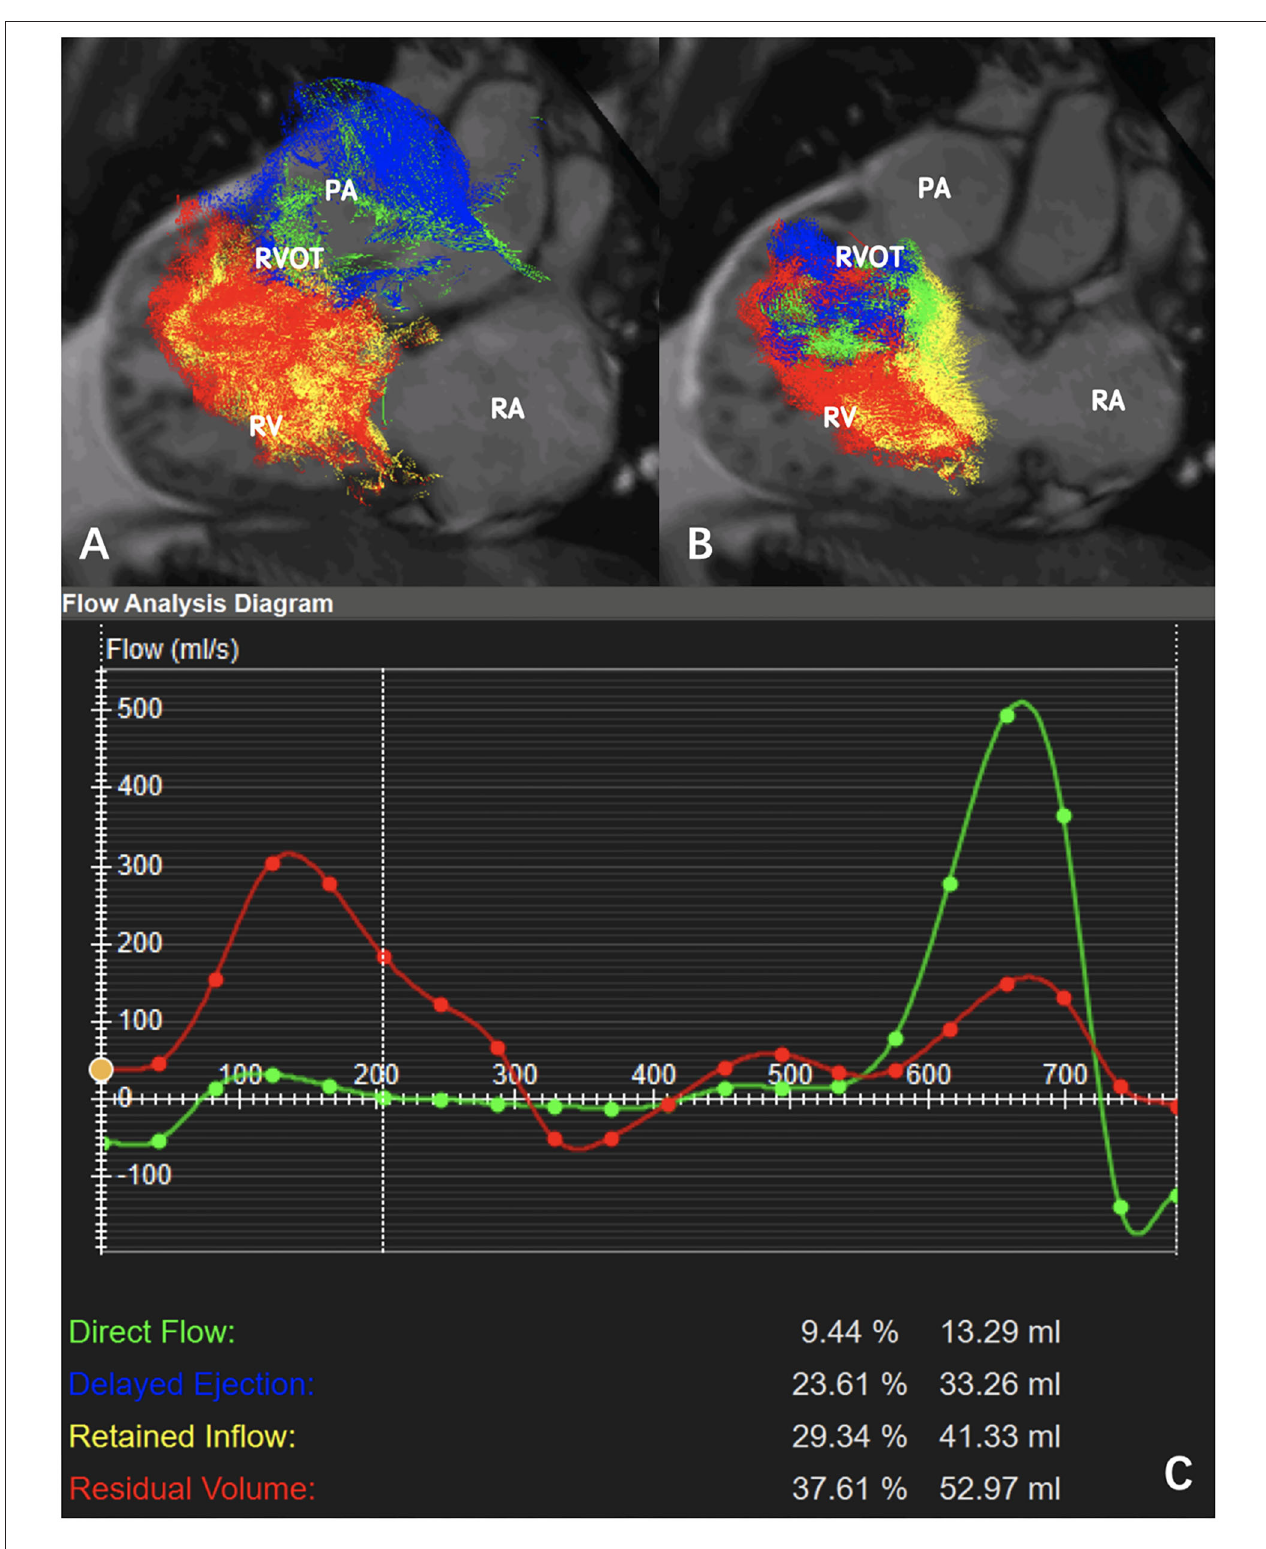
FIGURE 2 | Pathline visualization of right ventricular (RV) flow components in a patient with CTEPH (mean pulmonary arterial pressure = 50 mmHg, pulmonary vascular resistance = 12.26 Wood): (A) Pathline visualization of the RV flow components (direct flow, retained inflow, delayed ejection flow, and residual volume) in systole. (B) Pathline visualization of the RV flow components (direct flow, retained inflow, delayed ejection flow, and residual volume) in diastole. (C) Flow analysis diagram indicated PDF = 9.4%, PRI = 23.6%, PDFE = 29.3%, PRVo = 37.6% (RA: right atrium; RV: right ventricle; RVOT: right ventricular outflow tract; PA: pulmonary